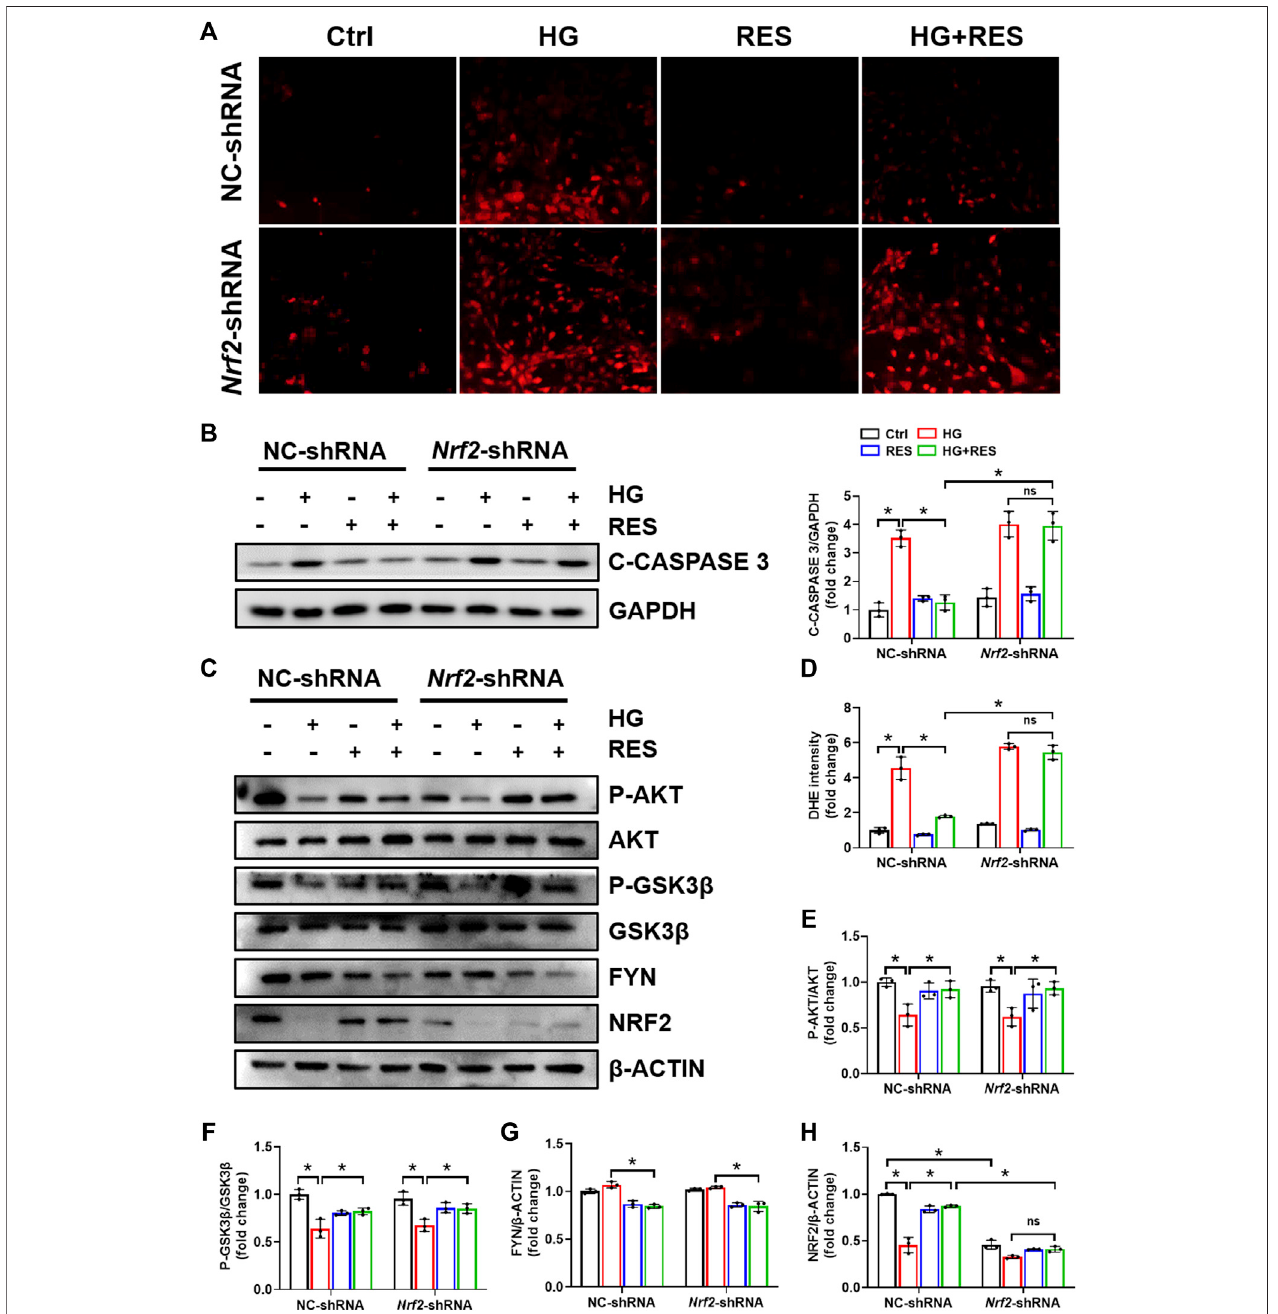
FIGURE 5 | Knockdown of Nrf2 eliminated the protective effect of RES on MC3T3-E1 cells injured by HG. Cells were transfected with NC-shRNA or Nrf2 - shRNA, followed by HG (30 mM), RES (5 μ M), neither, or both for 24 h. (A,D) Representative images of DHE staining and quantitative analysis of fl uorescence intensity in MC3T3-E1 cells. Three independent experiments were performed. (B) C-CASPASE 3 expression was analyzed by Western blot followed by densitometric quanti fi cation. GAPDH as an internal control. Three independent experiments were performed. (C,E – H) Western blot analysis of P-AKT, AKT, P-GSK3 β , GSK3 β , FYN, and NRF2 expression levels and densitometric quanti fi cation of related proteins in MC3T3-E1 cells. β -ACTIN as an internal control. Three independent experiments were performed. Data are shown as mean ± SD. * p < 0.05; ns indicates no signi fi cance.